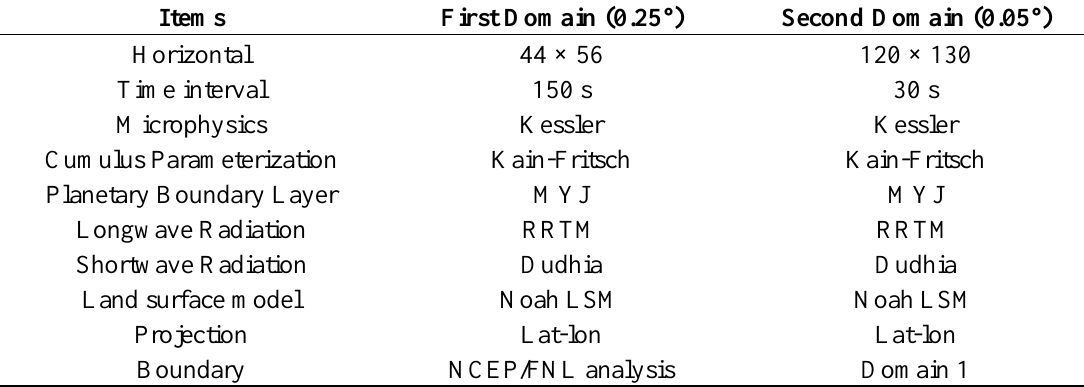
Table 2. WRF (Weather Research and Forecasting) physical configuration (microphysics) adopted in this